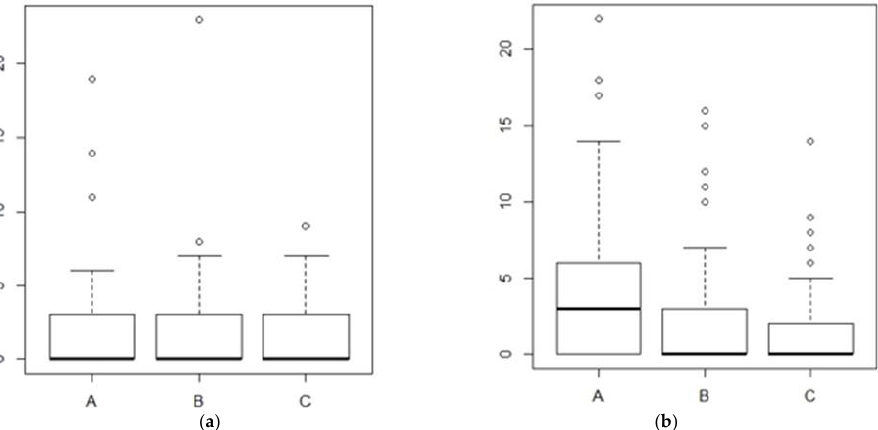
Figure 3. Comparison between preoperative ( a ) and postoperative VHI data ( b ) based on monitoring techniques. A = visual technique; B = intermittent nerve monitoring; C = continuous nerve monitoring.